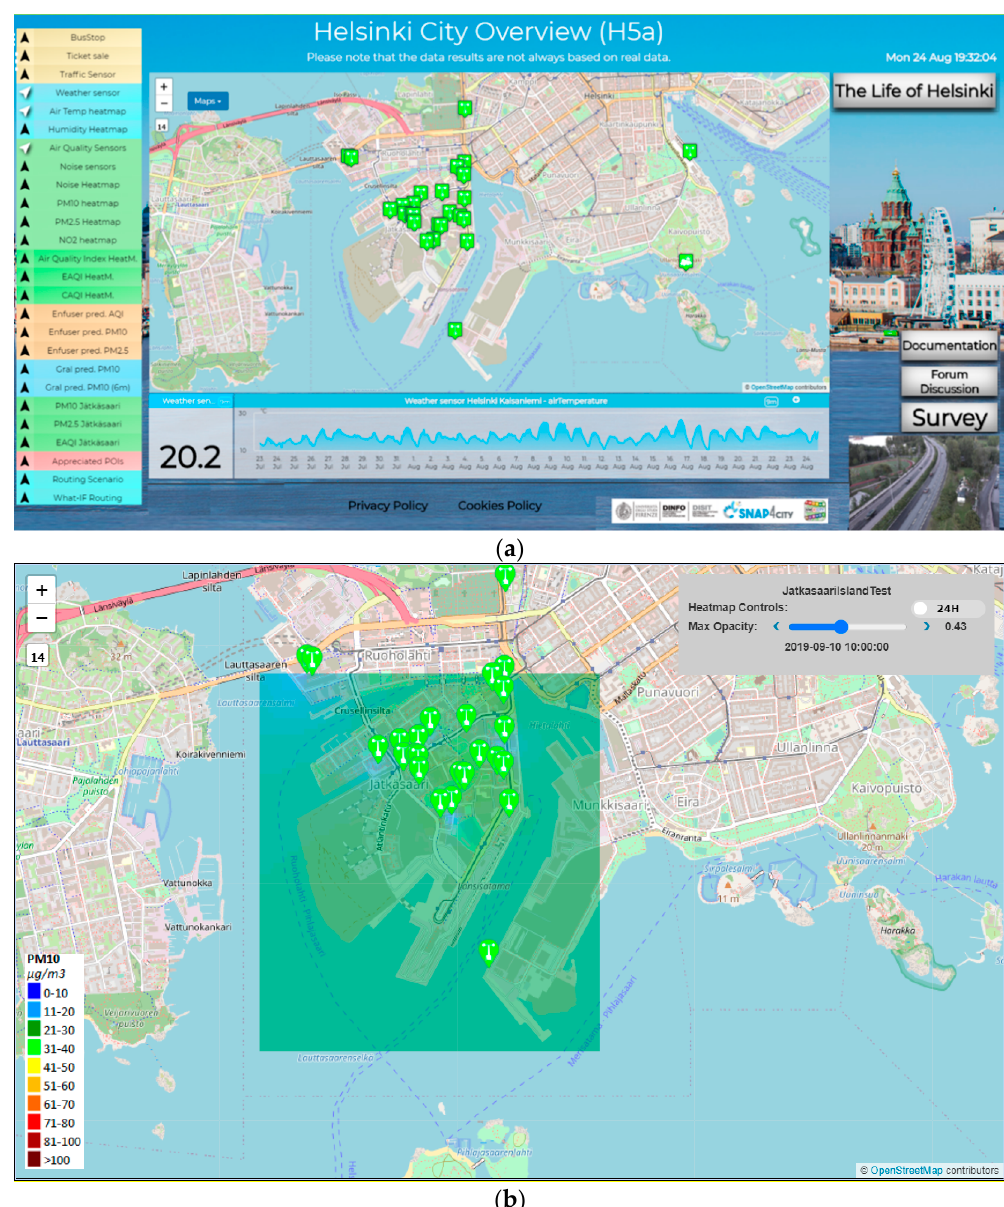
Figure 4. ( a ) Dashboard on Helsinki environmental aspects, the map presents an high density of sensors in the Jätkäsaari Island, ( b ) air quality PM 10 interpolation heatmap for a small area of Jätkäsaari Island (Inverse Distance Weighting (IDW) method), transparency set at 43%. The legend describes a colour map of 9 colours, while the heatmap is produced with a colour map with 150 colours.